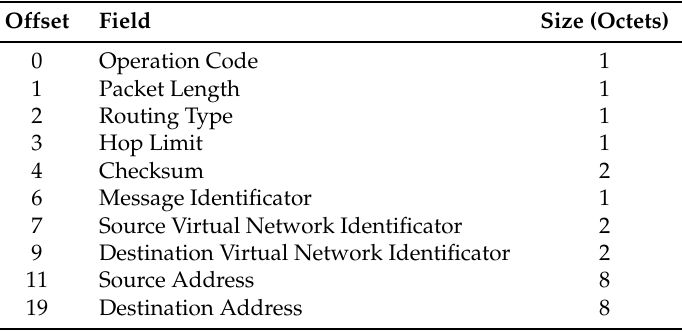
Table A1. DARAL control header